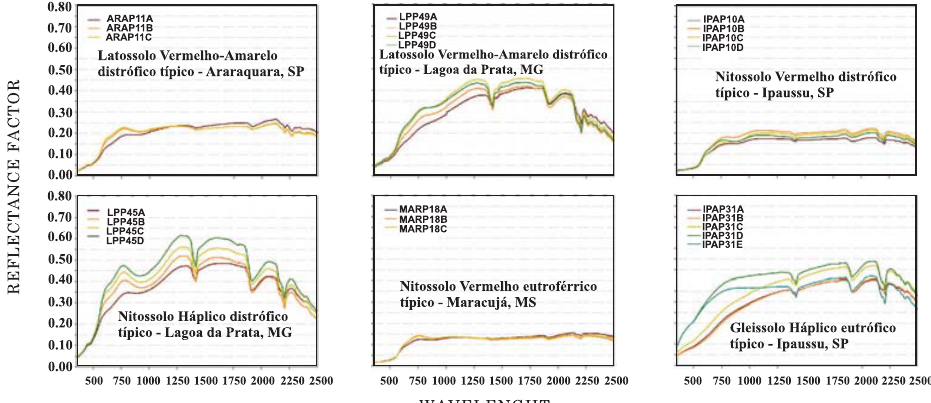
separationFigure 3. Spectral curves from soil profiles: Latossolos, Nitossolos and Gleissolos, representing the Soil Spectral Library.